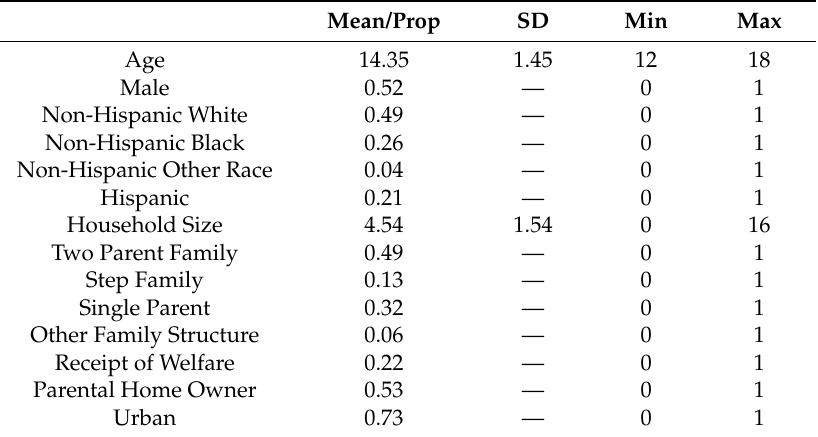
Table A1. Descriptive Statistics for Individual Characteristics (N = 1785).